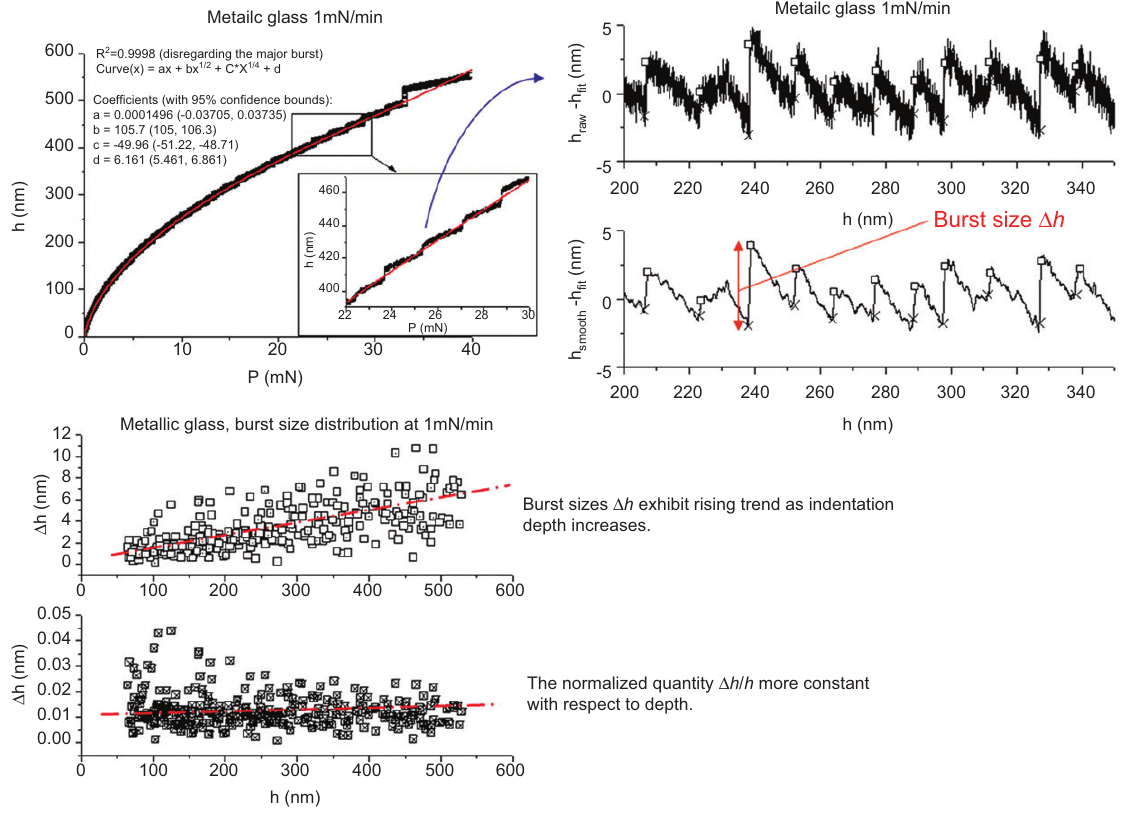
Figure 5 Jumpy flow in a zirconium-based bulk metallic glass during nanoindentation. Data from ref. [5]